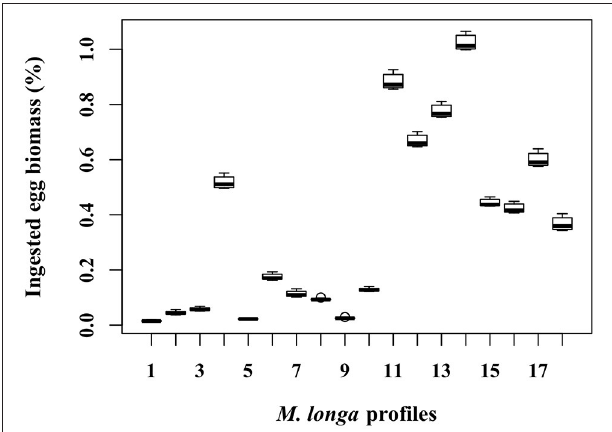
FIGURE 5 | Proportion of C. hyperboreus egg standing stock (%) ingested by female M. longa for all the 360 simulations with mean egg density (scenario D 0 ) and grouped according to each of the 18 in situ female M. longa abundance